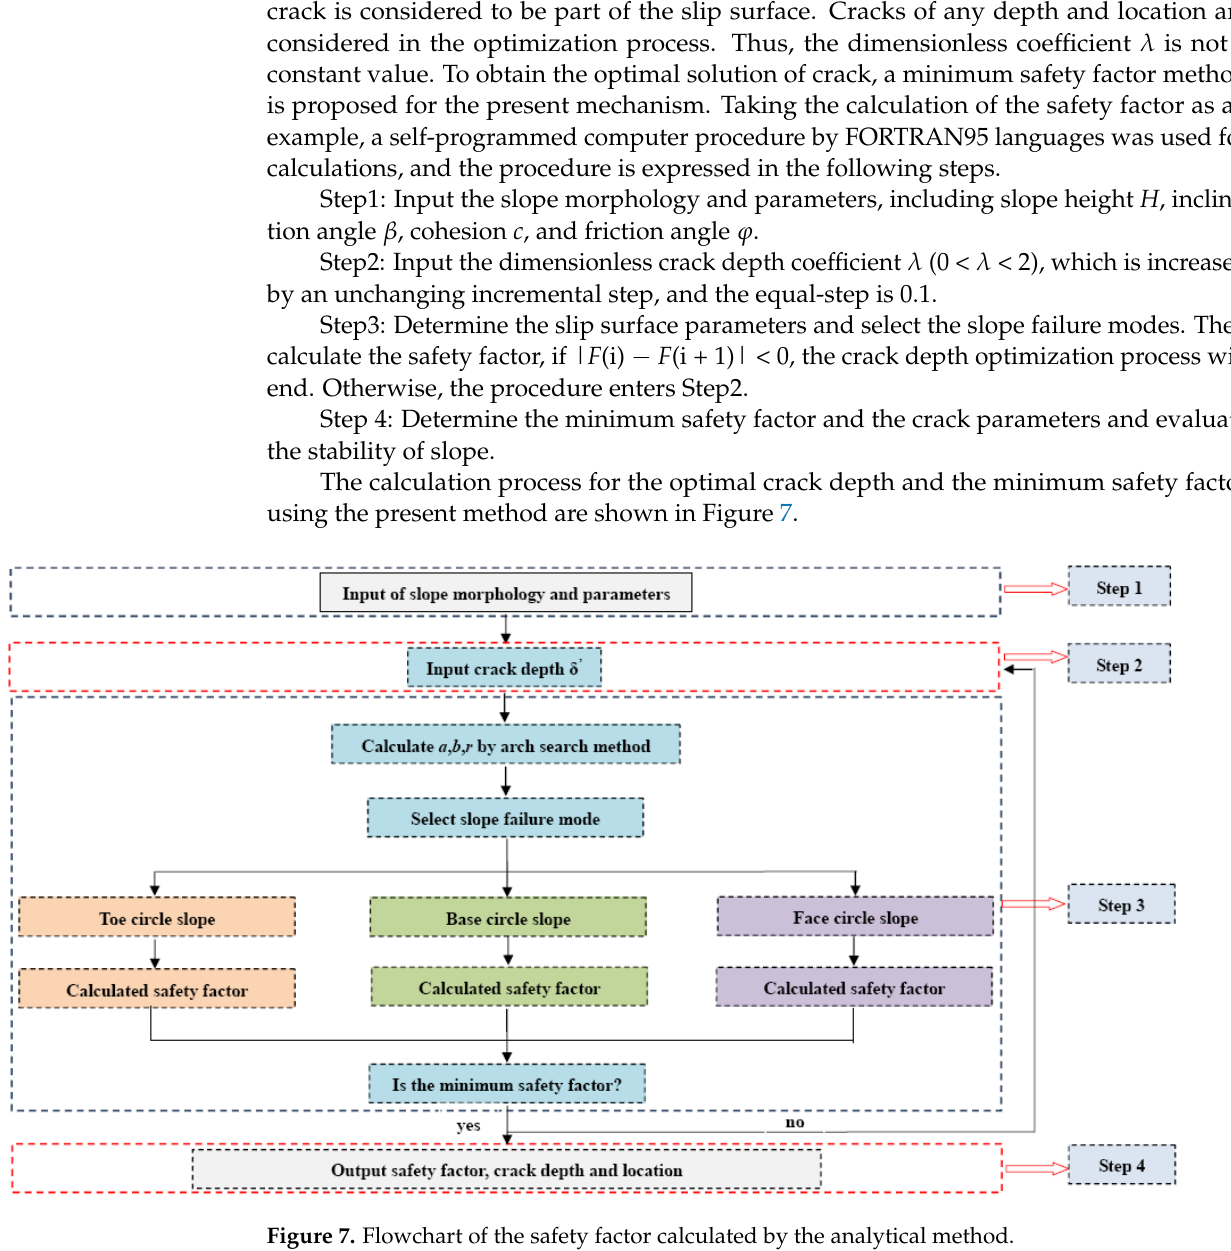
Table 1. Results of safety factor (case 1).